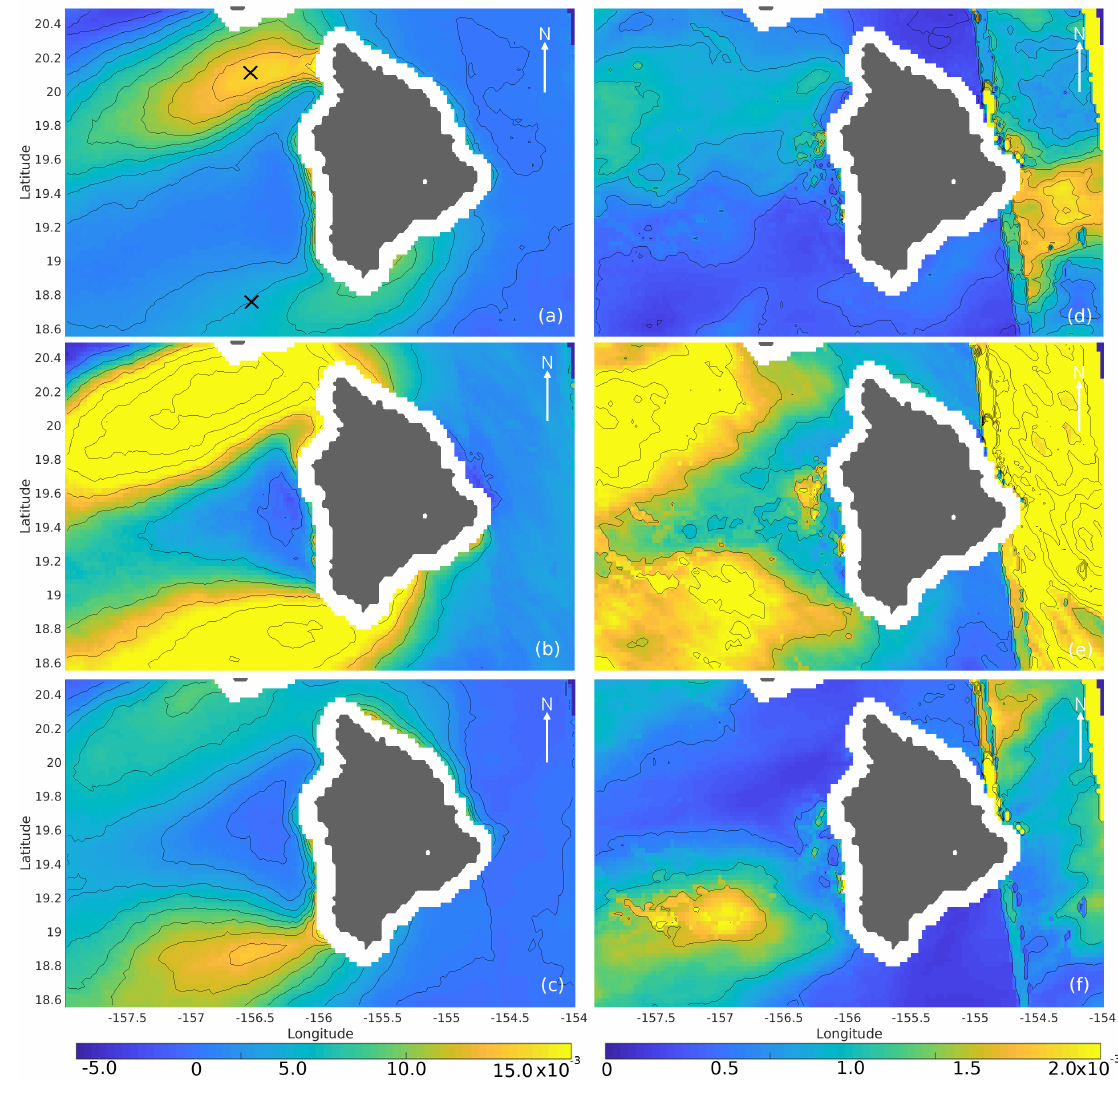
Figure 8. The average difference between linear values of measured ASCAT σ 0 and NWP predicted σ 0 shown for fore ( a ), mid ( b ), and aft ( c ) beams. Corresponding normalized standard deviation of the difference values are shown to the right in panels ( d–f ). The land is shown in gray and the land contamination buffer is shown in white. The Xs in ( a ) indicate where the wind speeds are taken from for the plots in Figure